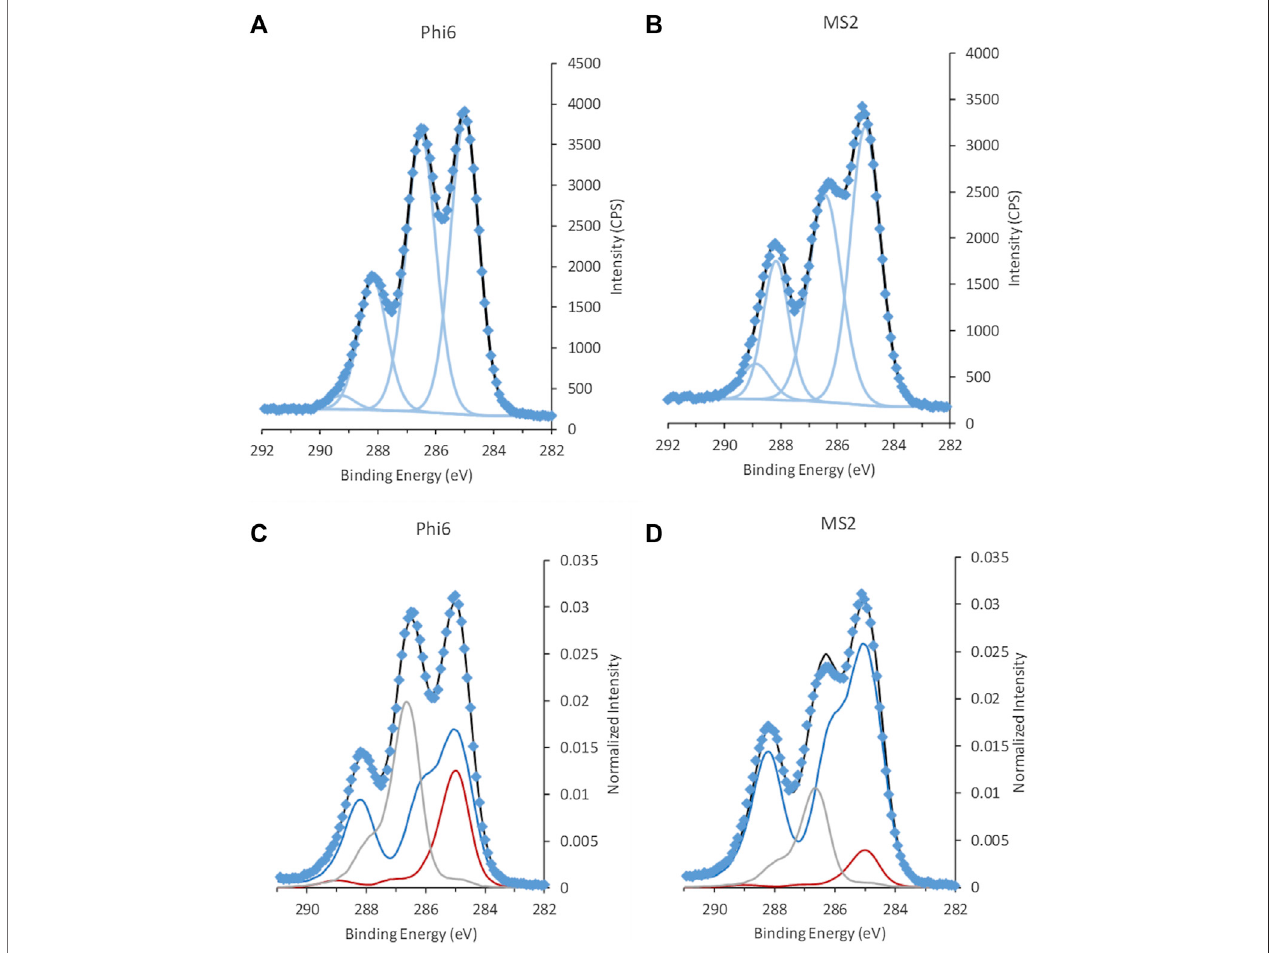
FIGURE 6 | C 1s spectra from the two bacteriophages (A,C) Phi6 and (B,D) MS2, fi tted with GL30 peak shapes (A,B) and spectral components (C,D) . Data is represented by blue diamonds, the fi t by a solid black line, GL30 peak shapes are represented by light blue lines in fi gures (A,B) , and in (C,D) the blue line represents protein-like substance, grey line polysaccharides and red line lipid-like